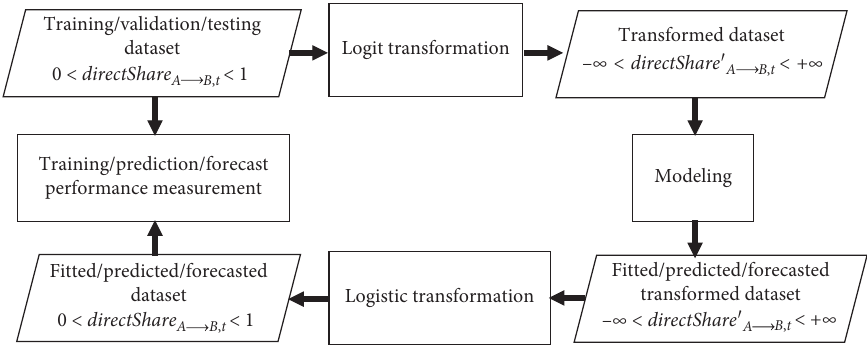
Figure 2: Direct share modeling process with logit and logistic transformations.